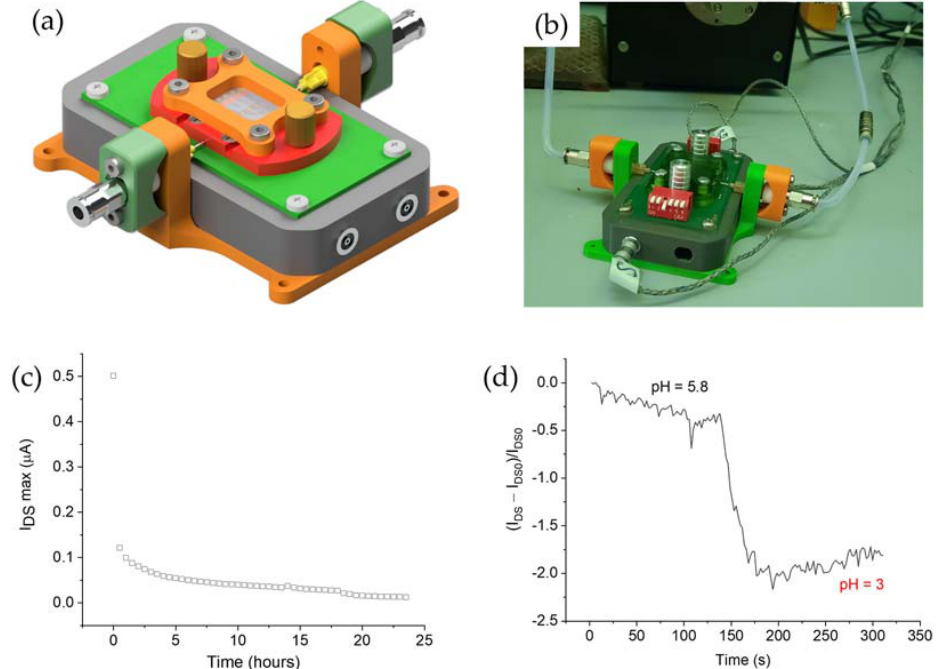
Figure 6. ( a ) The rendered 3D model of the flow chamber. ( b ) A photo of the assembled flow chamber during the experiment. ( c ) Stability test (cyclic measurements, 1 transfer curve per 30 min) in the flow mode (5 mL/min). ( d ) Transient measurements in flow mode with HCl acid addition.